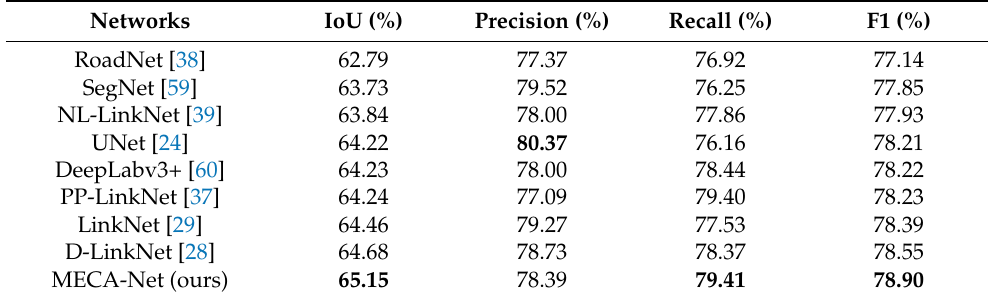
Table 1. Quantitative evaluation results of different networks on the DeepGlobe dataset.